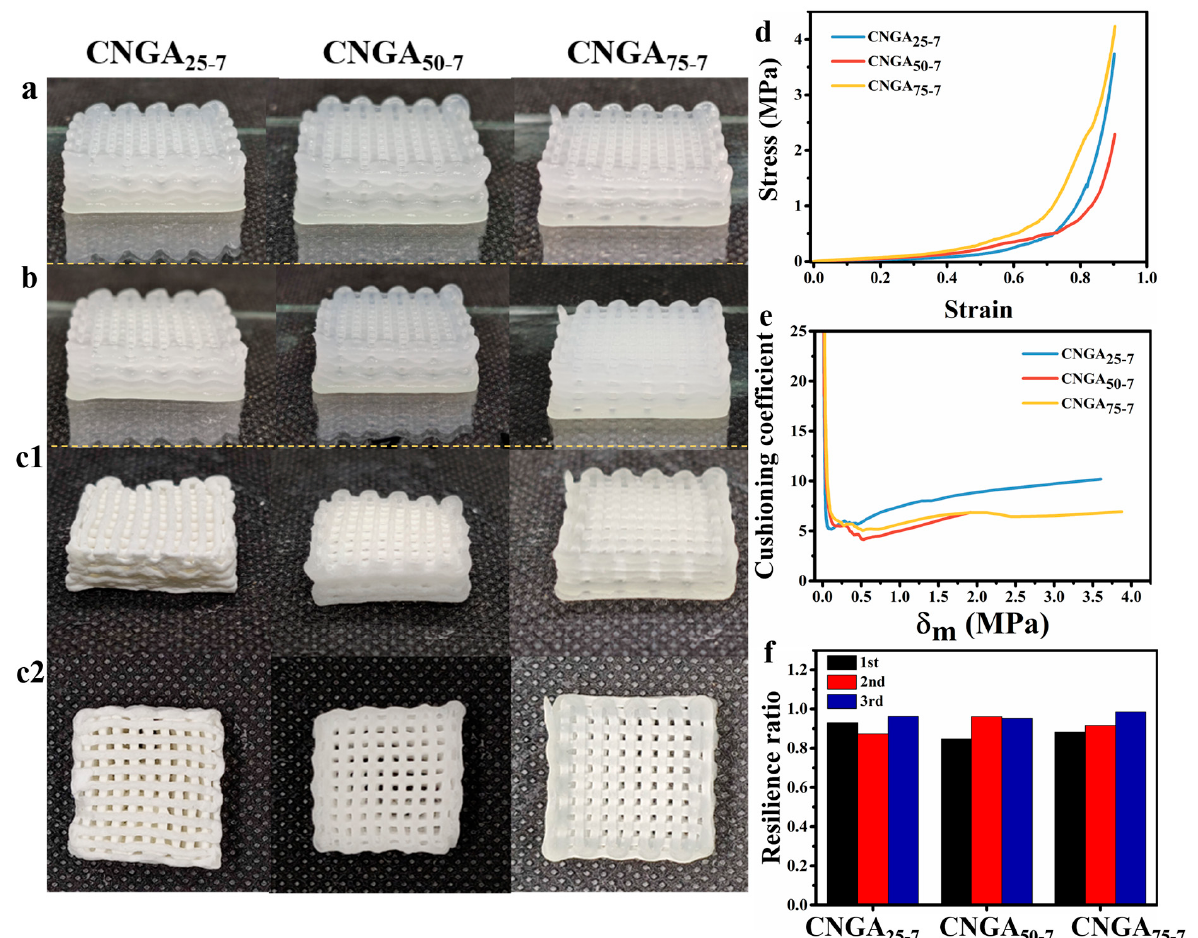
Figure 3. Morphology of 3D-printed samples by CMC-based inks with different glycerin content ( a ) before and ( b ) after UV curing and ( c1 , c2 ) after freeze drying. ( d ) Stress–strain curve, ( e ) cushioning curves, and ( f ) thrice compression resilience ratio of samples with different glycerin content.